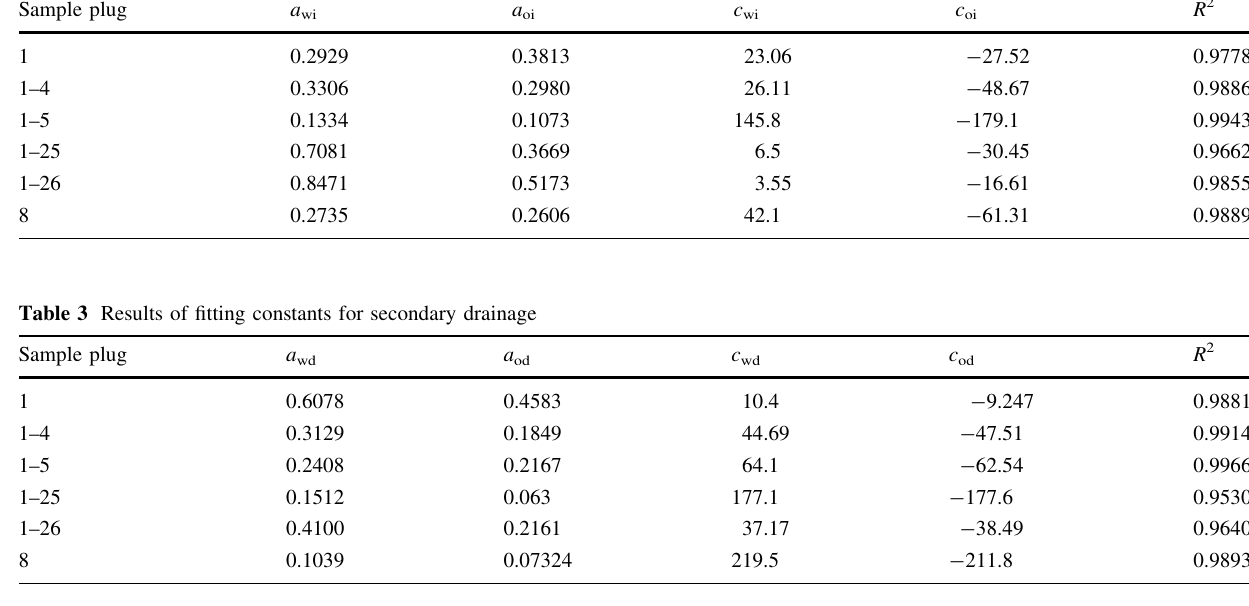
Fig. 2 MATLAB user interface example of imbibition P c curve fitting for core plug #8 Table 2 Results of fitting constants for imbibition Sample plug